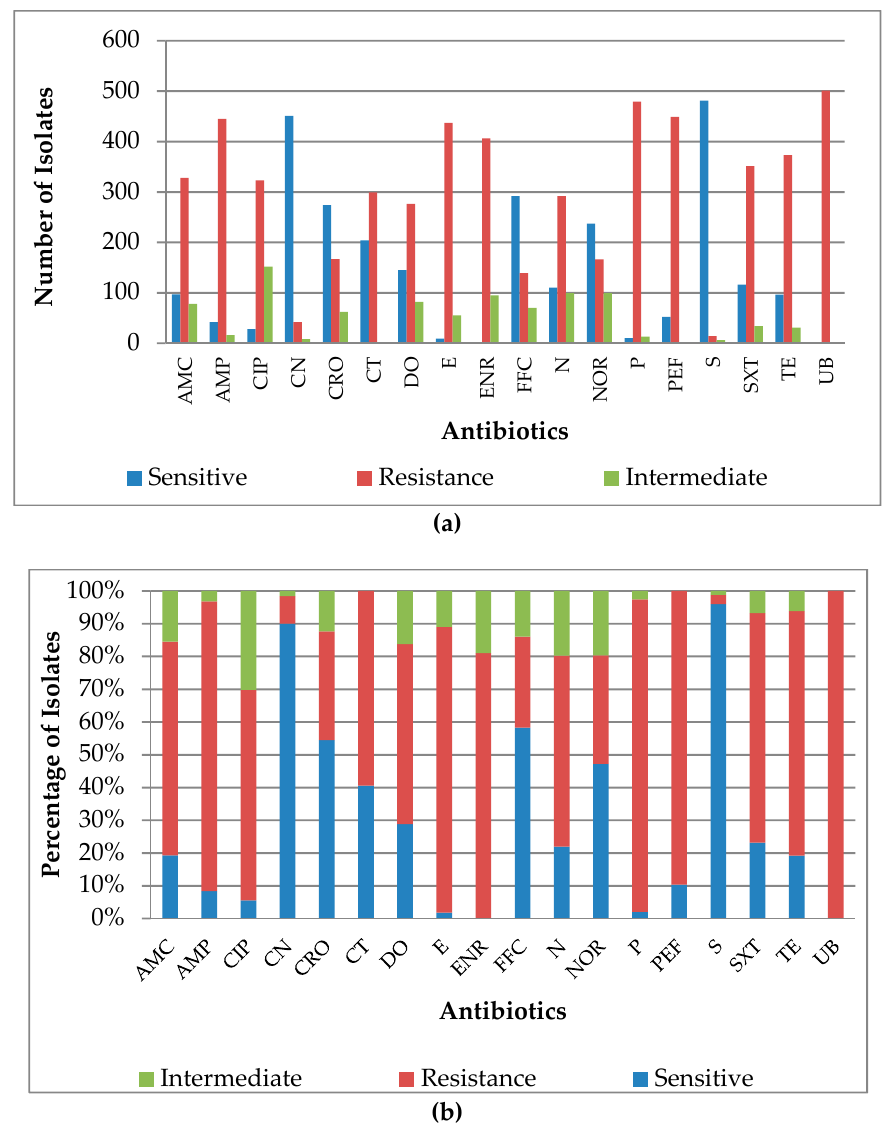
Figure 3. Resistance profile of 507 Salmonella isolates from the Nigeria broiler production value chain. ( a ) Distribution of resistance of 507 Salmonella isolates from the Nigeria broiler production value chain to each antibiotic; ( b ) Resistance profile of 507 Salmonella isolates from the Nigeria broiler production value chain to each antimicrobial. Note: AMC = Amoxicillin clavulanic 30 µ g, AMP = Ampicillin 10 µ g, CIP = Ciprofloxacin = 5 µ g, CN = Gentamycin 120 µ g, CRO = Ceftriaxone 30 µ g, CT = Colistin 10 µ g, DO = Doxycycline 30 µ g, E = Erythromycin 15 µ g, ENR = Enrofloxacin 5 µ g, FFC = Florfenicol 30 µ g, N = Neomycin 30 µ g, NOR = Norfloxacin 10 µ g, P = Penicillin G 10 µ g, PEF = Perfloxacin 5 µ g, S = Streptomycin 300 µ g, SXT = Co-trimoxazole (Trimethoprim-Sulphamethoxazole) 25 µ g, TE = Tetracycline 30 µ g, UB = Flumequine 30 µ g.